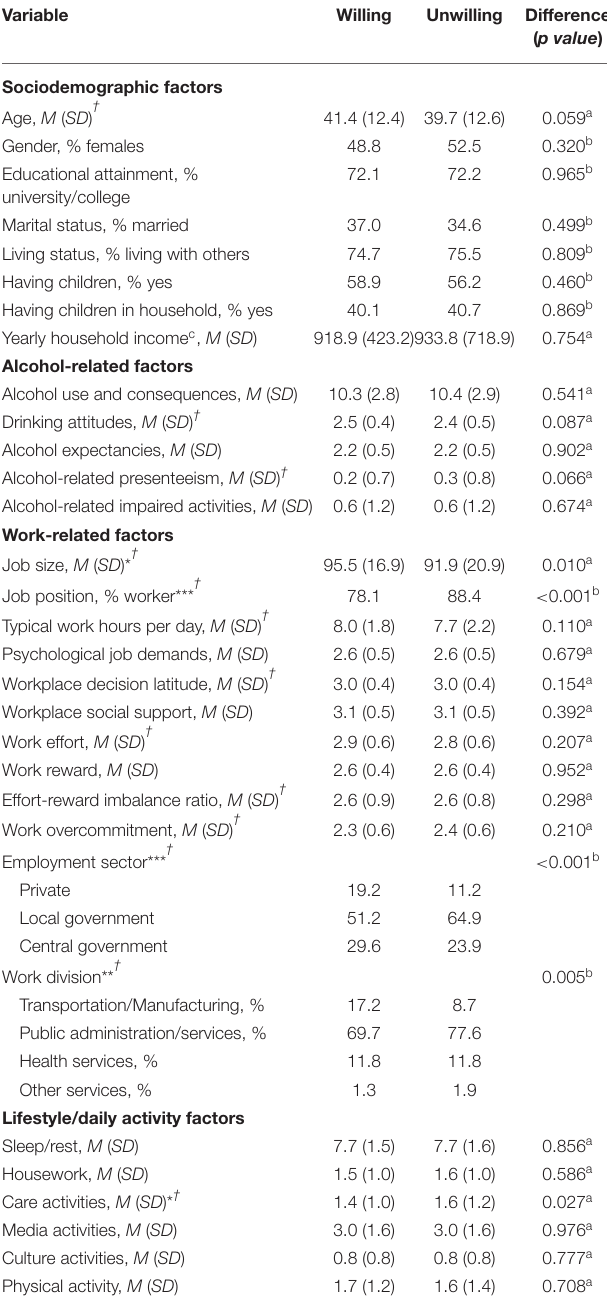
TABLE 2 | Unadjusted associations with willingness to participate.